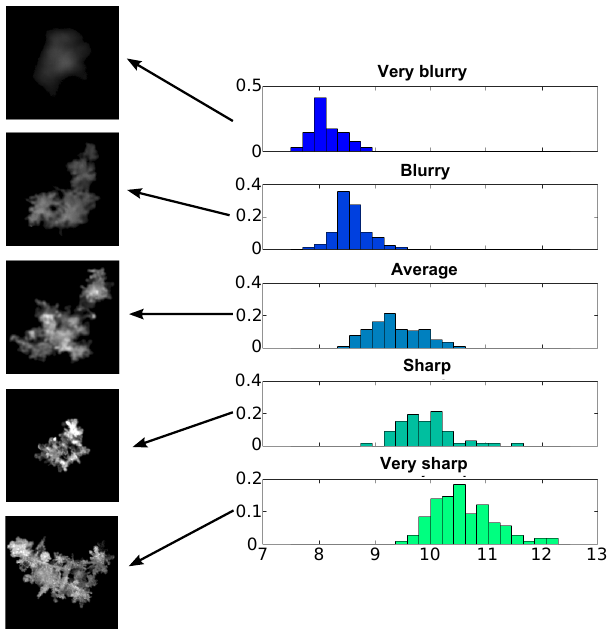
Figure B1. Distribution of the quality index ξ within the 5 cate- gories of snowflakes manually classified.